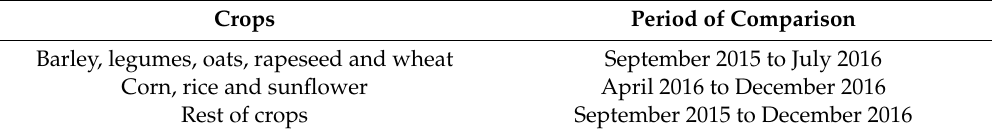
Table 3. Period of time considered for the comparison depending on the crop type. Crops